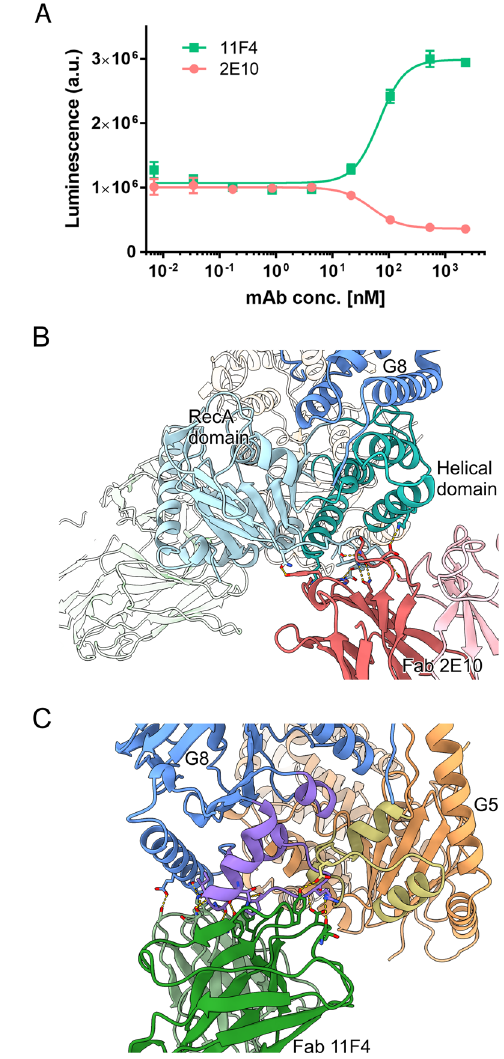
Fig. 3 Binding of antibodies to the NBD modulates the ATPase activity of ABCG5/G8. A ATPase activity of ABCG5/G8 in the presence of mAb 2E10 or 11F4. mAb 2E10 decreases the ATPase activity of ABCG5/G8 with an IC 50 of 49.4nM. mAb 11F4 increases the ATPase activity of ABCG5/G8 with an EC 50 of 67.2 nM. B The interaction interface between Fab 2E10 and ABCG8 NBD. The helical and RecA domain of ABCG8 NBD are colored in teal and cyan, respectively. C The interaction interface between Fab 11F4 and ABCG5/G8. The three-helix bundle with 296 NPFDFYMD 303 motif in ABCG5 and 316 NPADFYVD 323 motif in ABCG8 are colored in yellow and purple,